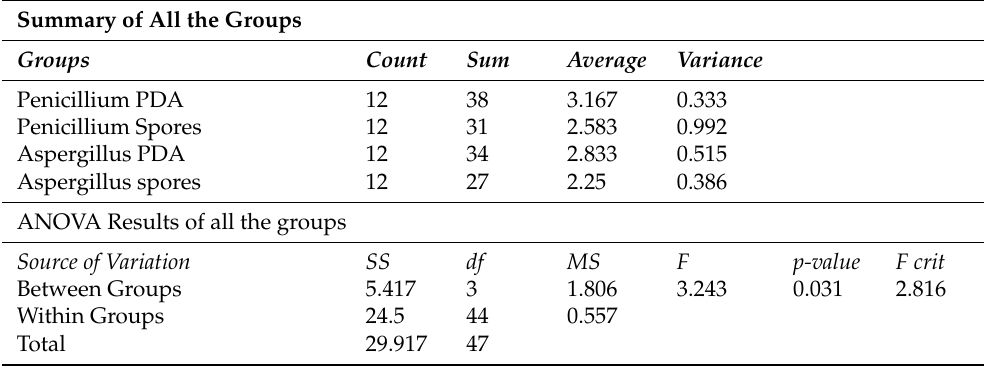
Table A1. ANOVA Single Factor Results obtained from the values of the damages produce on glass by Penicillium and Aspergillus with PDA and in Tween.